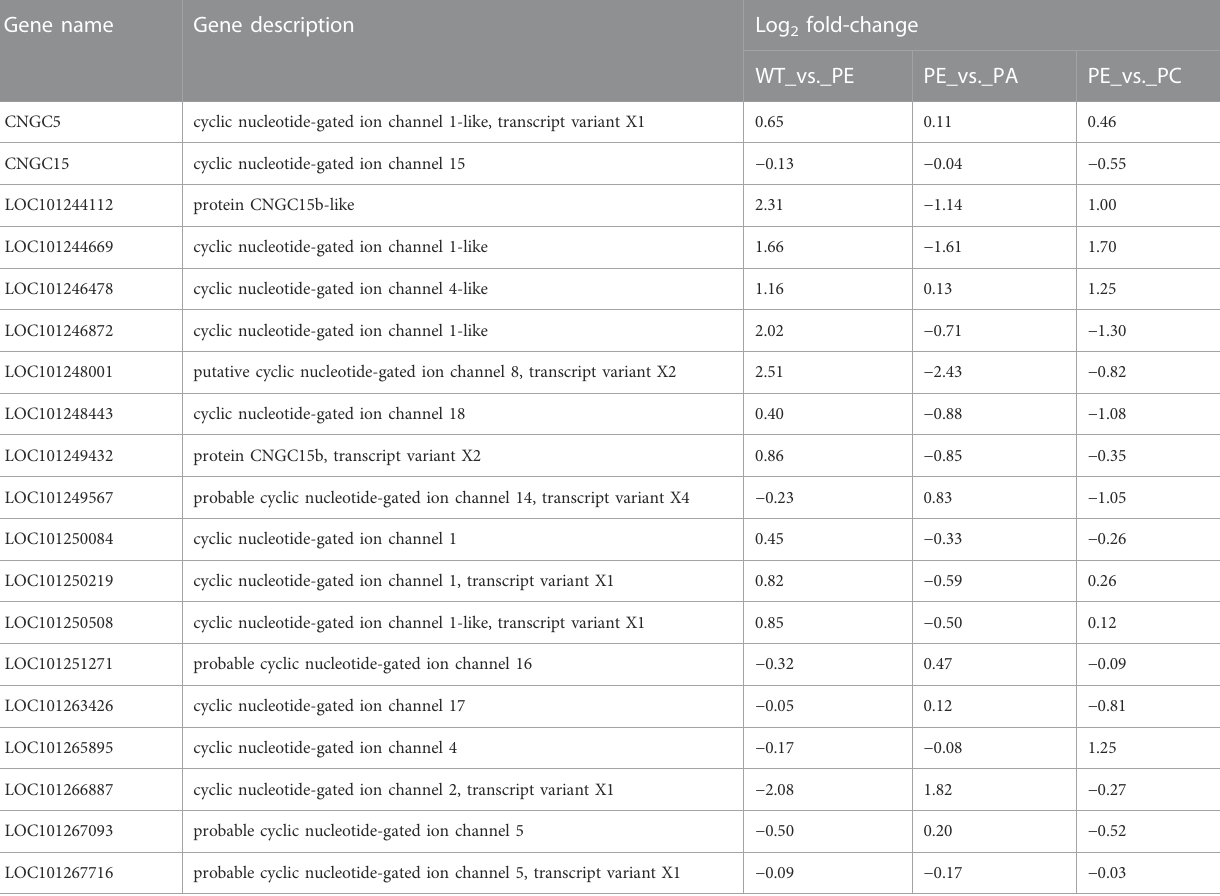
TABLE 3 Tomato cyclic nucleotide-gated ion channel gene expression in WT_vs._PE, PE_vs._PA, and PE_vs._PC comparison groups. Gene name